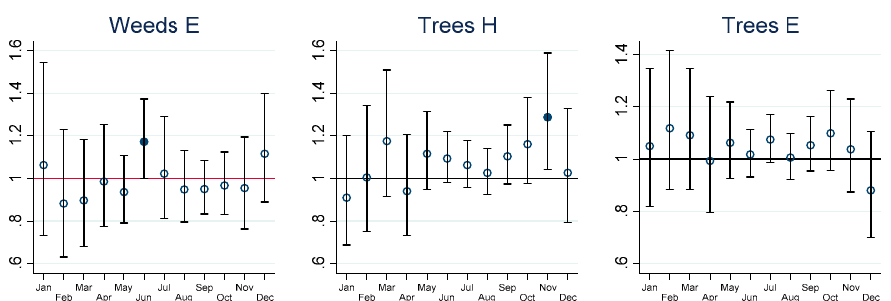
Figure 3. Short-term incidence rate ratios (IRRs) in adults for lower respiratory health outcomes.